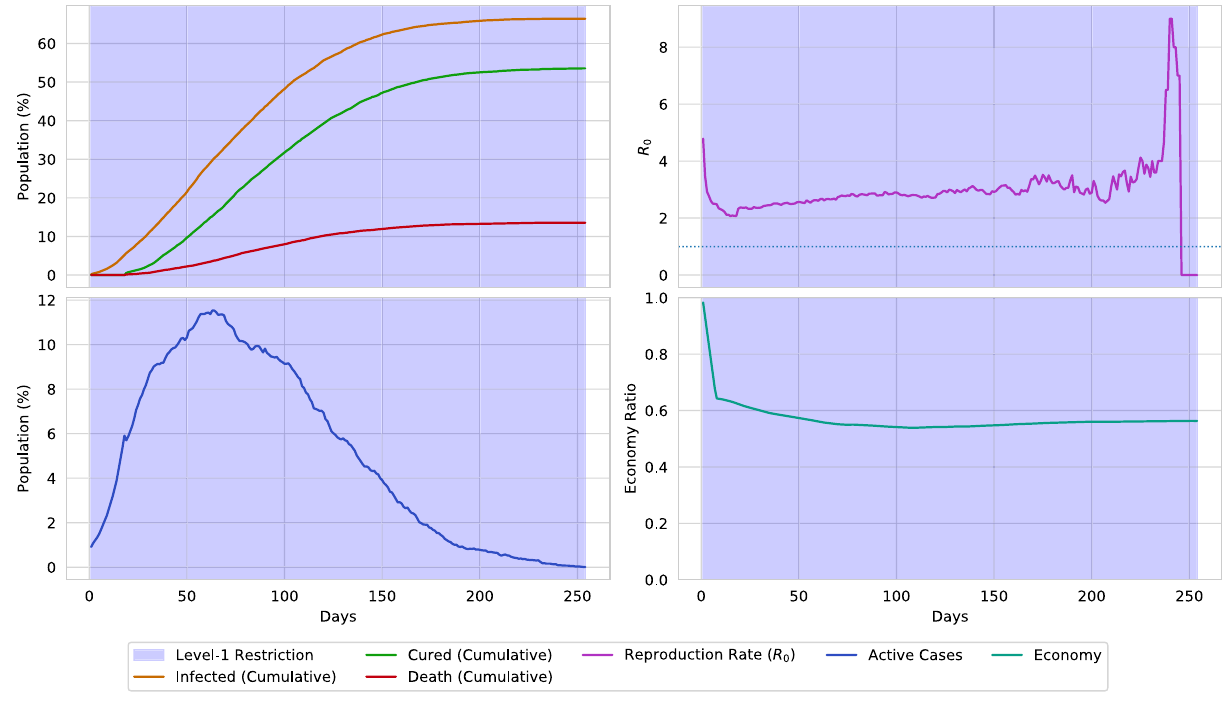
Figure 17. A simulation of the virtual environment (0.02 population density) only if social-distancing is maintained. Due to social-distancing, the spread of the disease is reduced. Hence, the total number of infections is reduced by 20%, along with a reduction in deaths by 10%. Although the economical ratio is reduced by 0.2, it is considerate, relating to the reduced spread of the virus.